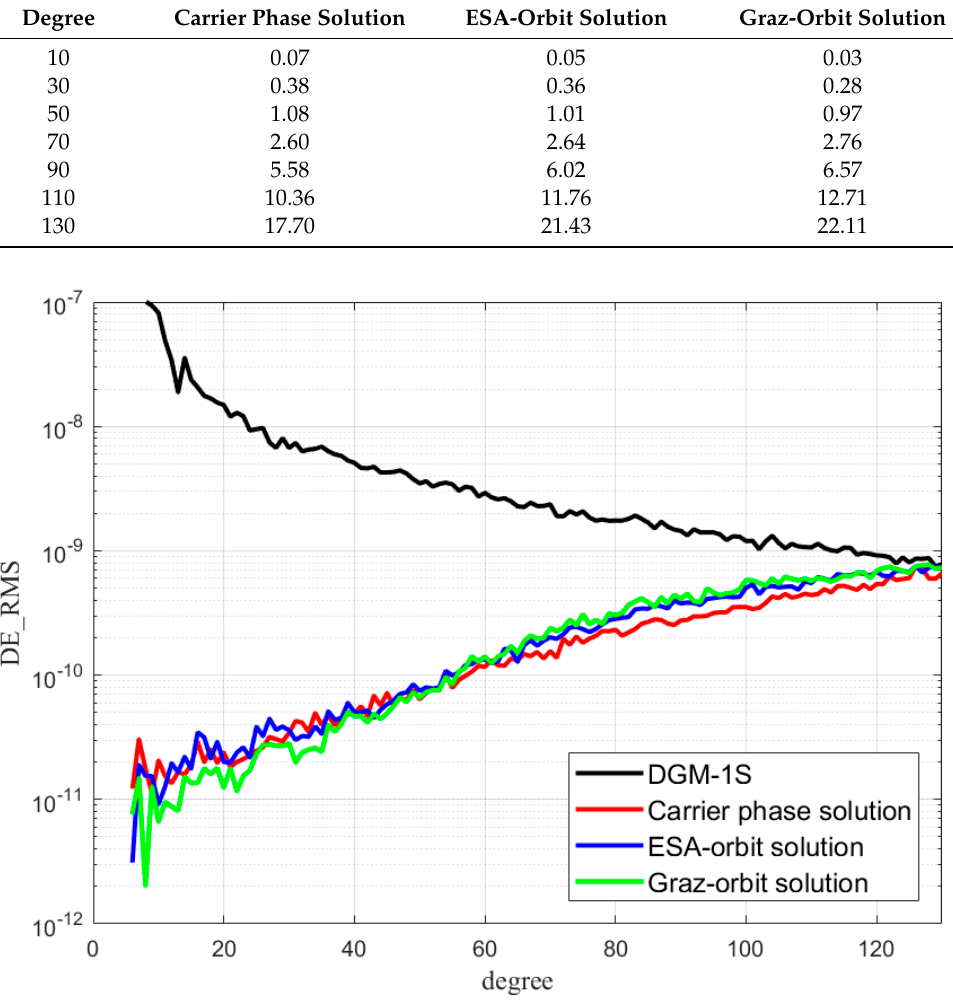
Figure 6. DE-RMS of the recovered spherical harmonic coefficients w.r.t. DGM-1S. Table 7. Cumulative geoid height differences (unit: cm) w.r.t. DGM-1S up to different degrees.